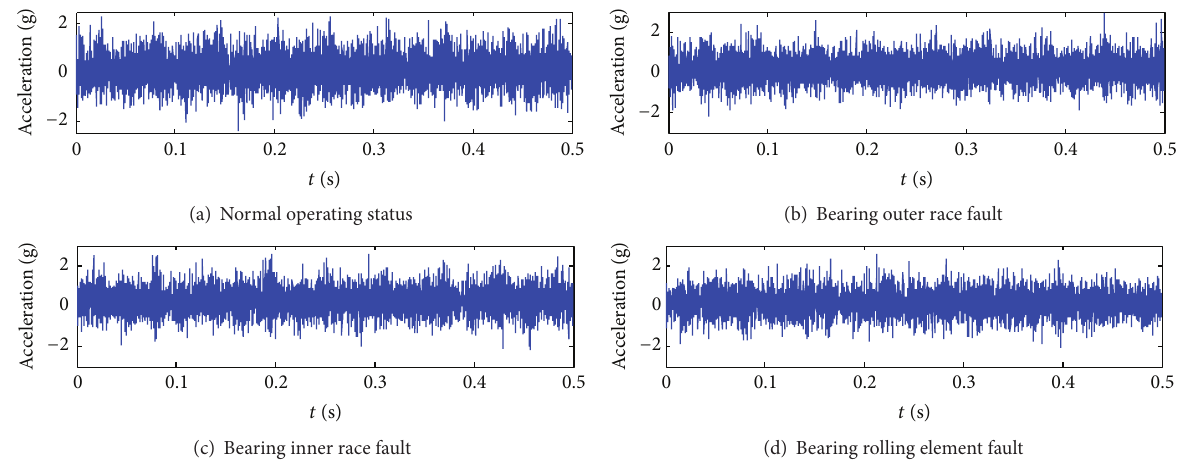
Figure 6: The original signal waveforms in different status of rolling bearing.